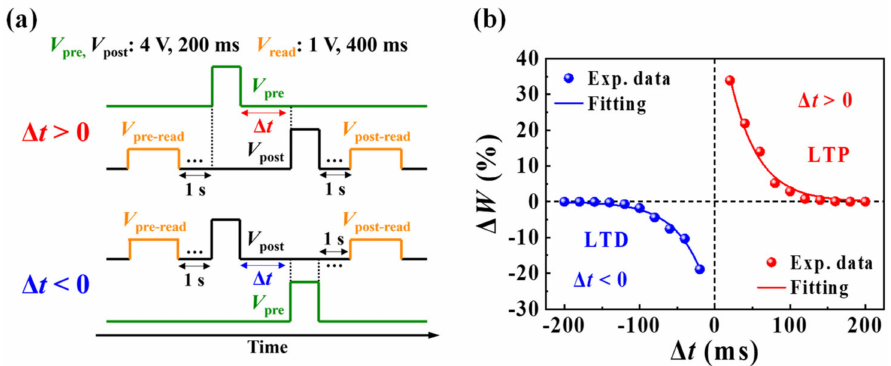
Figure 6. ( a ) Schematic of the spike sequence based on the relative timing difference between post- and pre-synaptic spikes ( ∆ t ). ( b ) Synaptic weight change ( ∆ W ) as a function of ∆ t , which demonstrates the biological asymmetric Hebbian learning spike-timing-dependent plasticity (STDP) function.